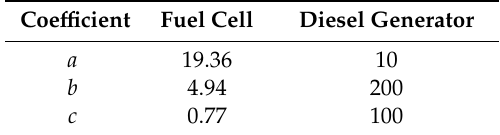
Table 2. Cost coe ffi cients of the dispatchable sources of the microgrid. Table 2 . Cost coefficients of the dispatchable sources of the microgrid .